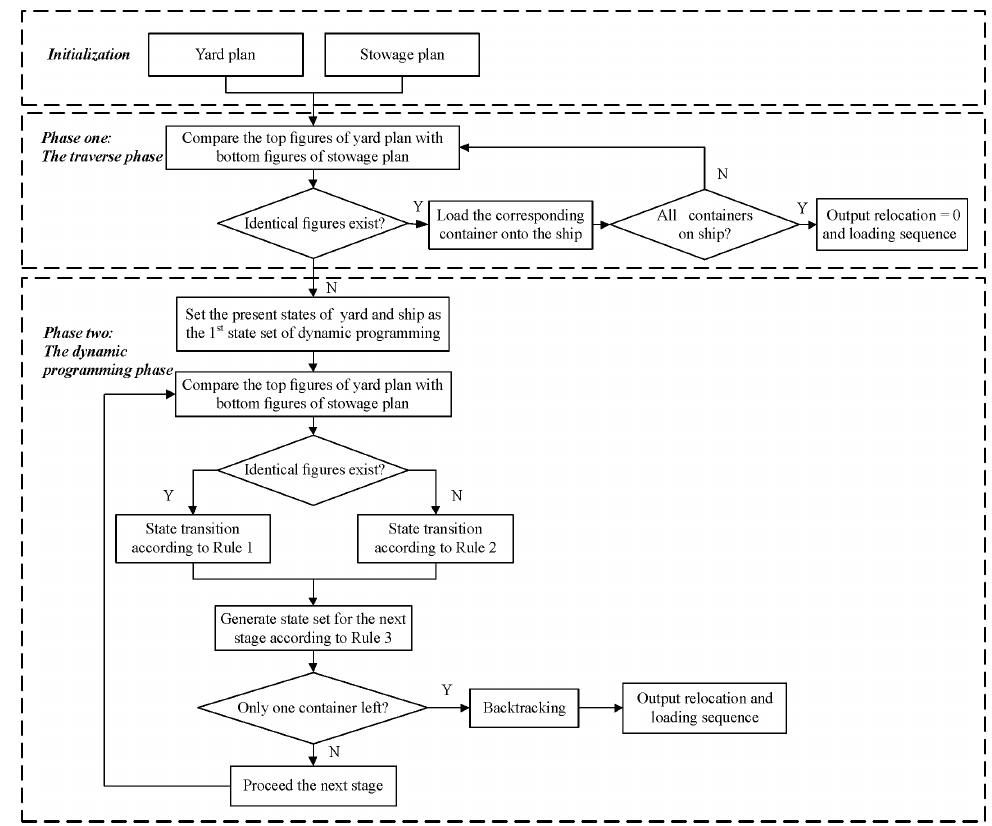
Fig. 5. The framework of hybrid dynamic